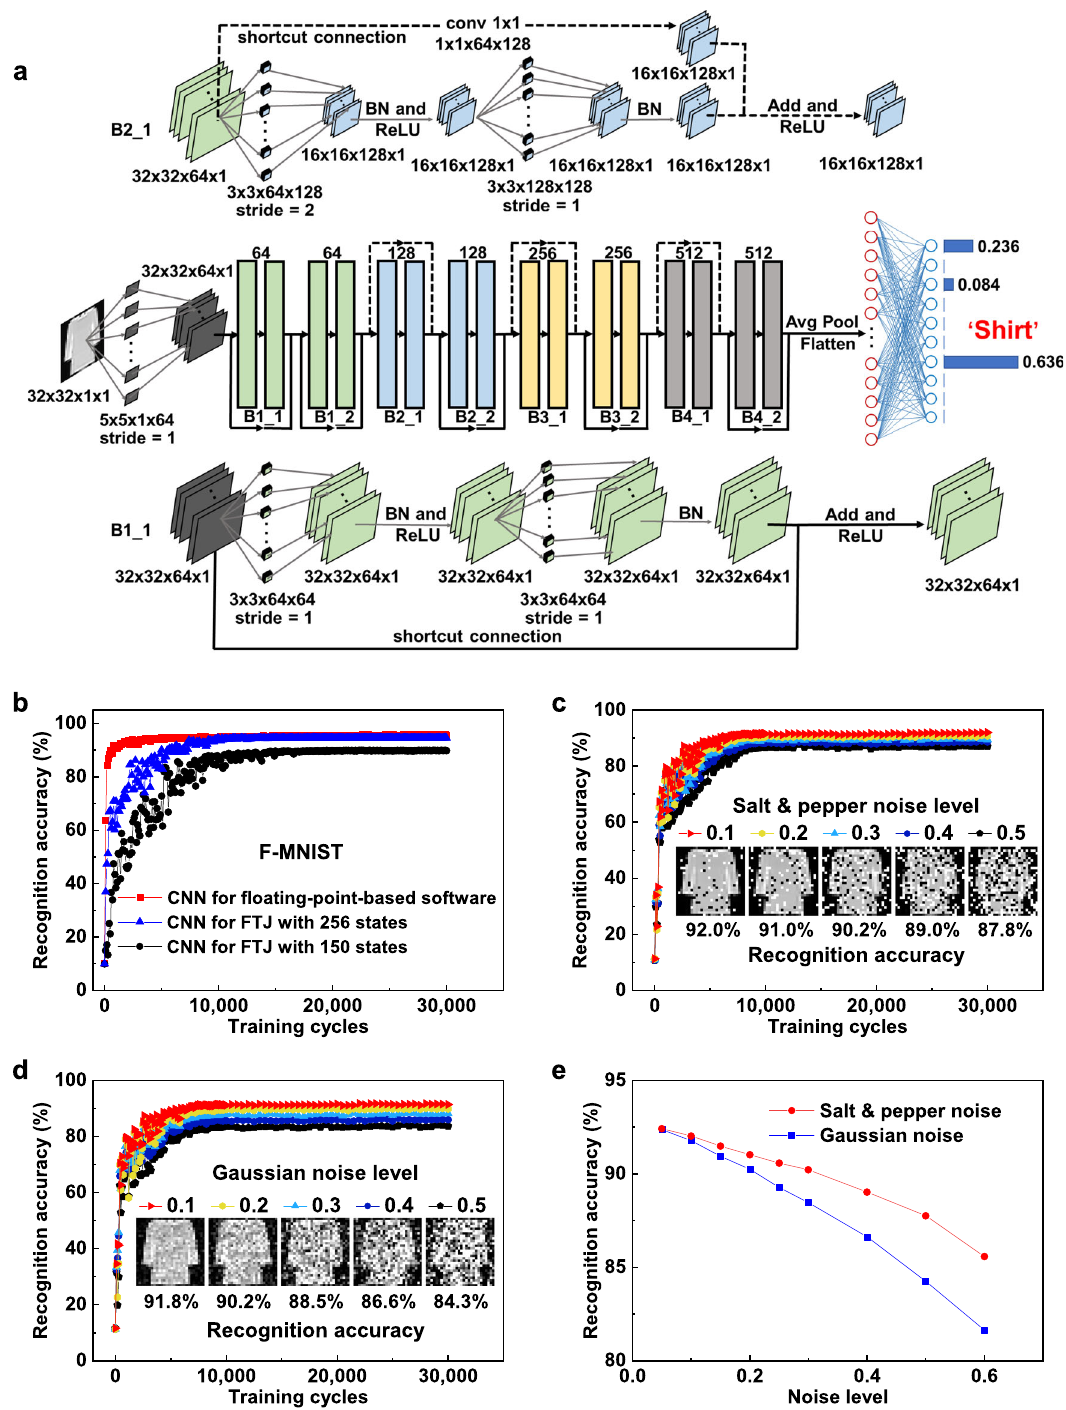
Fig. 7 Neural network simulation. a Schematic diagram of the ResNet-18 neural network. b Simulation results on learning F-MNIST images based on the experimental results of 256 (in Fig. 6a) and 150 (in Fig. 6b) conductance states as well as fl oating-point-based software. c , d Training results on F-MNIST images with different levels of salt & pepper noise and Gaussian noise, respectively. e Recognition accuracy of F-MNIST images with different levels of salt & pepper noise and Gaussian